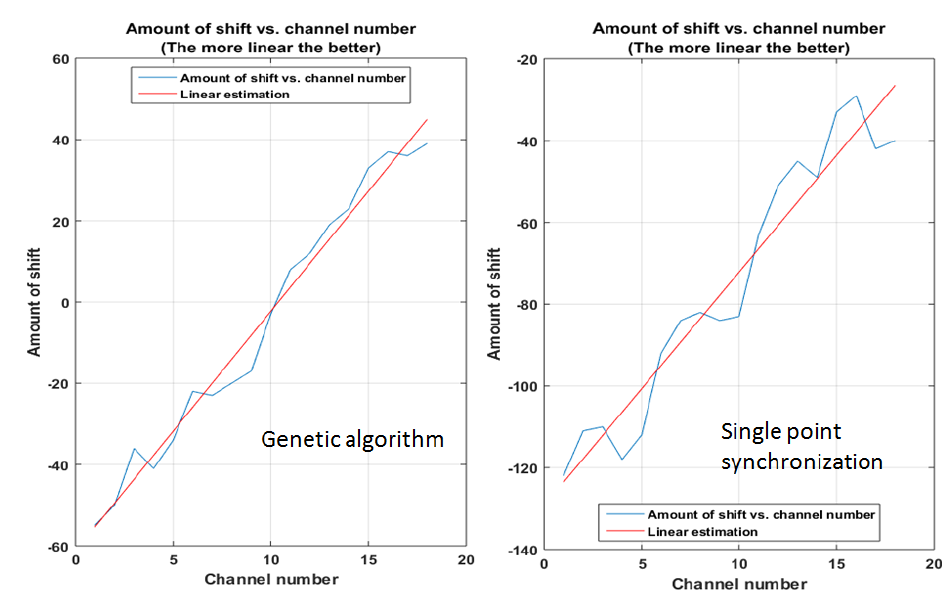
Figure 16. Linearity comparison for the faulty